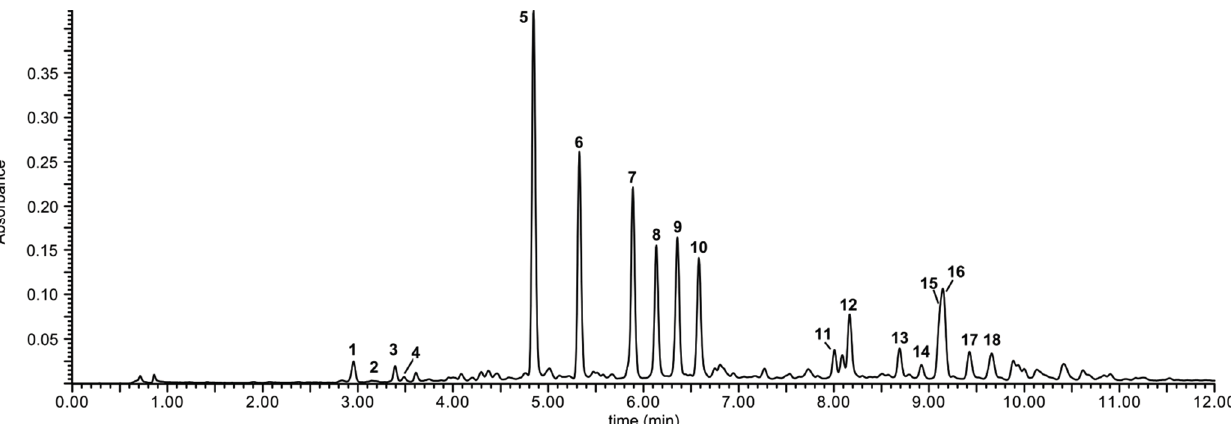
Figure 1. UPLC-UV (330 nm) chromatogram of the crude extract from the aerial parts of lentil (Lens culinaris ).